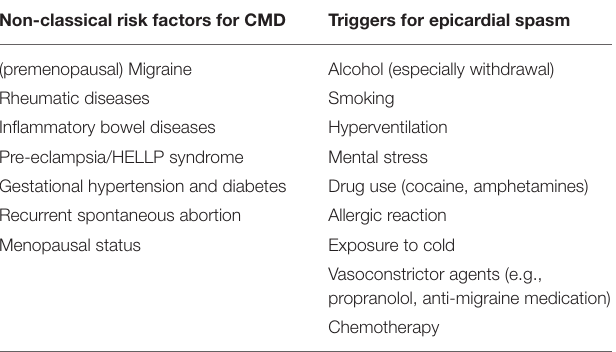
TABLE 1 | Non-classical risk factors and triggers playing a role in ANOCA. Non-classical risk factors for